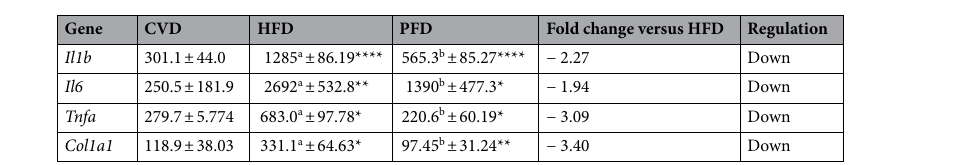
Table 2. Gene expression of proinflammatory cytokines and Collagen Type I. Data are expressed in mean ± SEM. CVD conventional diet, HFD high fat and high carbohydrate diet, PFD high fat diet +